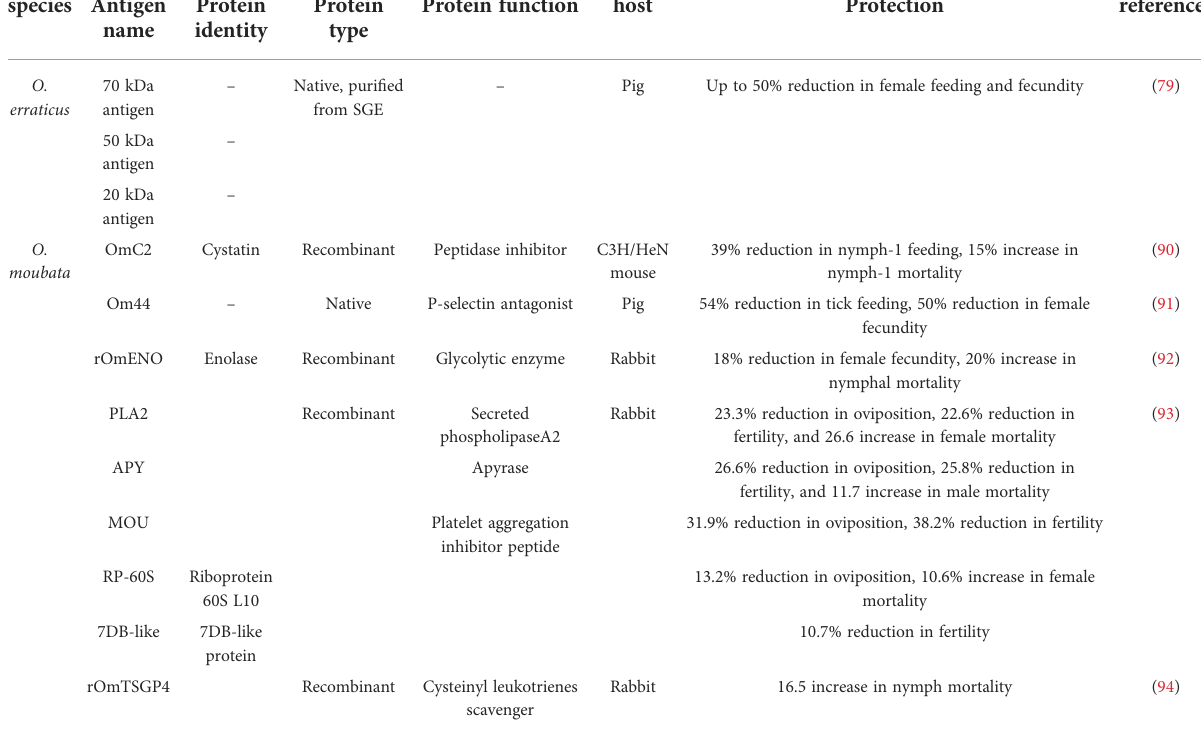
TABLE 3 Effective vaccines using salivary antigens from Ornithodoros species. species Antigen